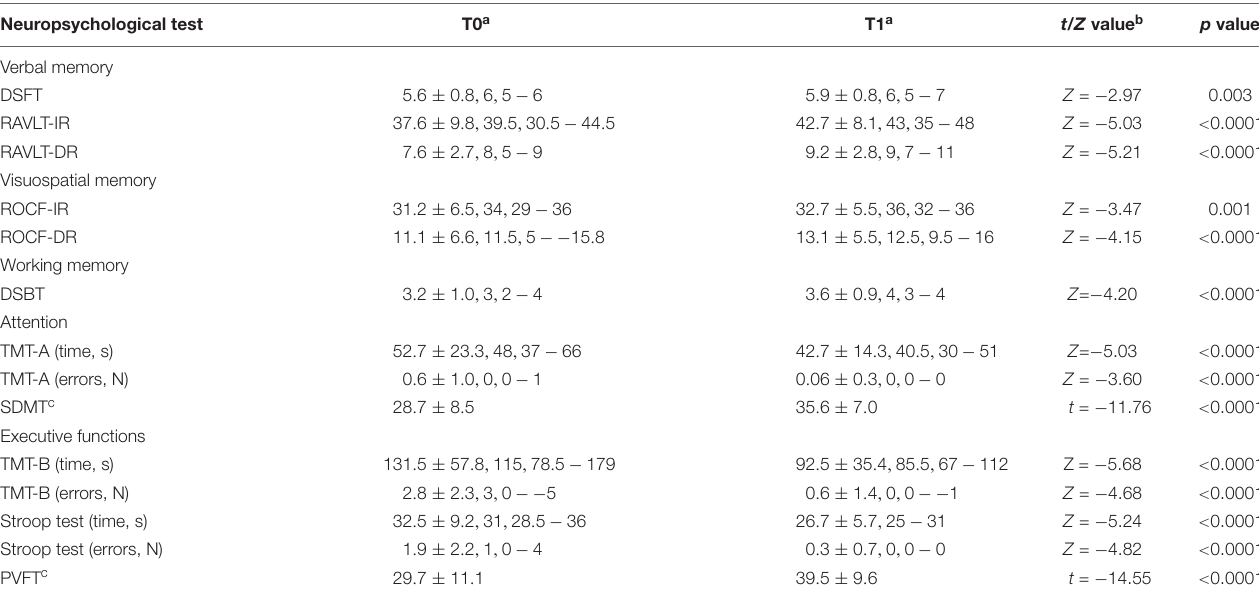
TABLE 3 | Comparison of neuropsychological measures in high-dose BZD abusers at T0 and T1. Neuropsychological